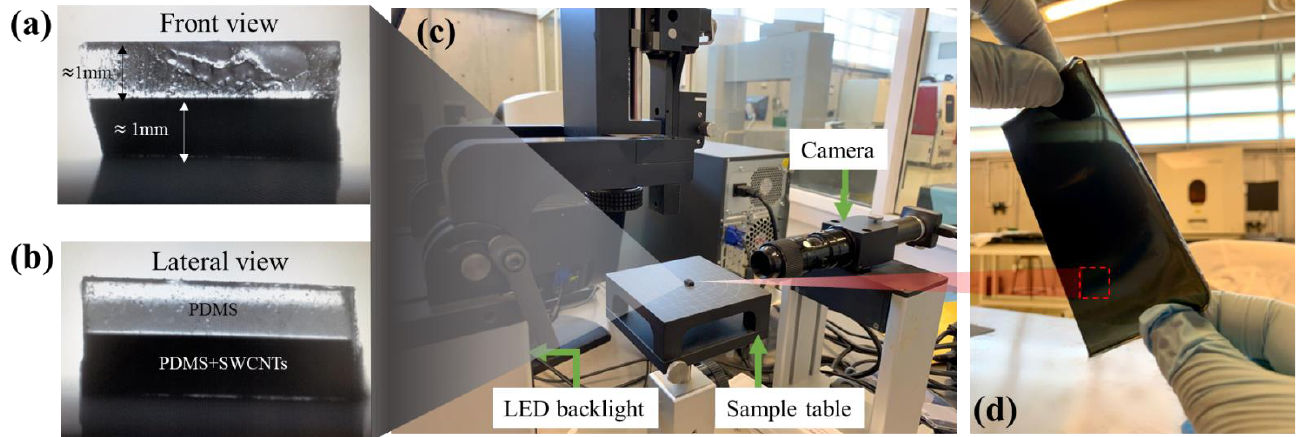
Figure 3. Doubled layer films ( a ) Front view; ( b ) Lateral view; ( c ) Setup for cross-sectional thickness inspection of film samples; ( d ) Translucent flexible film with minimum filler loading of 0.5 wt.%.